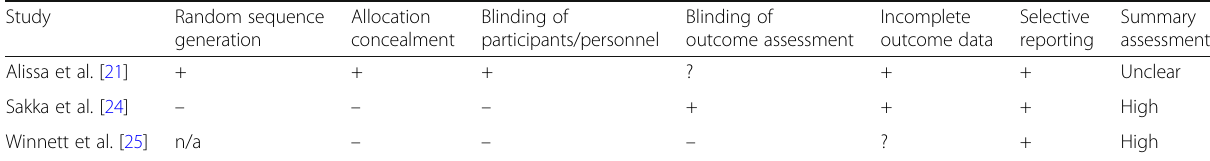
Table 3 Quality and bias assessment of human clinical studies using The Cochrane Collaboration ’ s Tool [17]